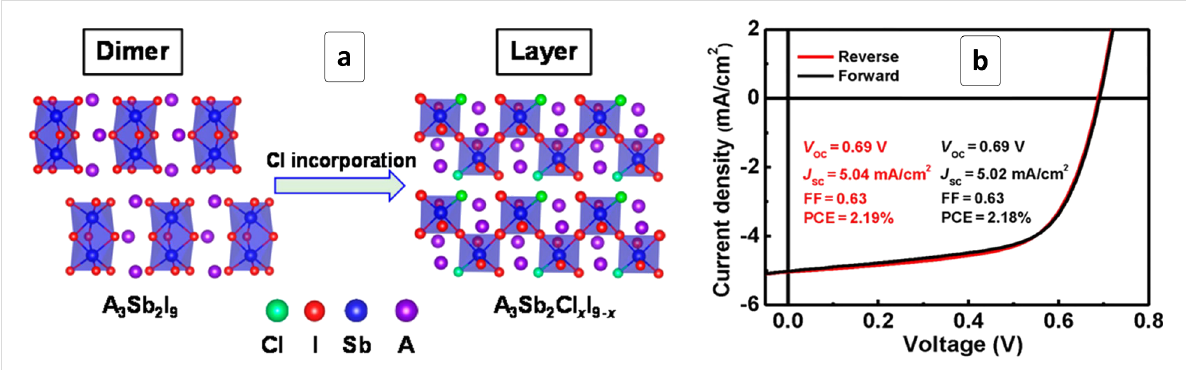
Figure 12: Schematic structure of MASb 2 Cl x I 9 − x HP (a) and current–voltage characteristics of a solar cell based on MA 3 Sb 2 Cl x I 9 − x HP registered at a forward and reverse bias (b). Reprinted and adapted with permission from [154], copyright 2018 American Chemical Society.